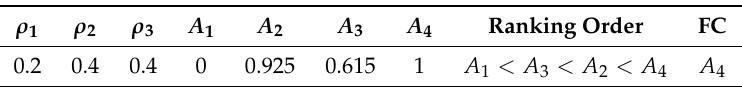
Table 12. Primary risk